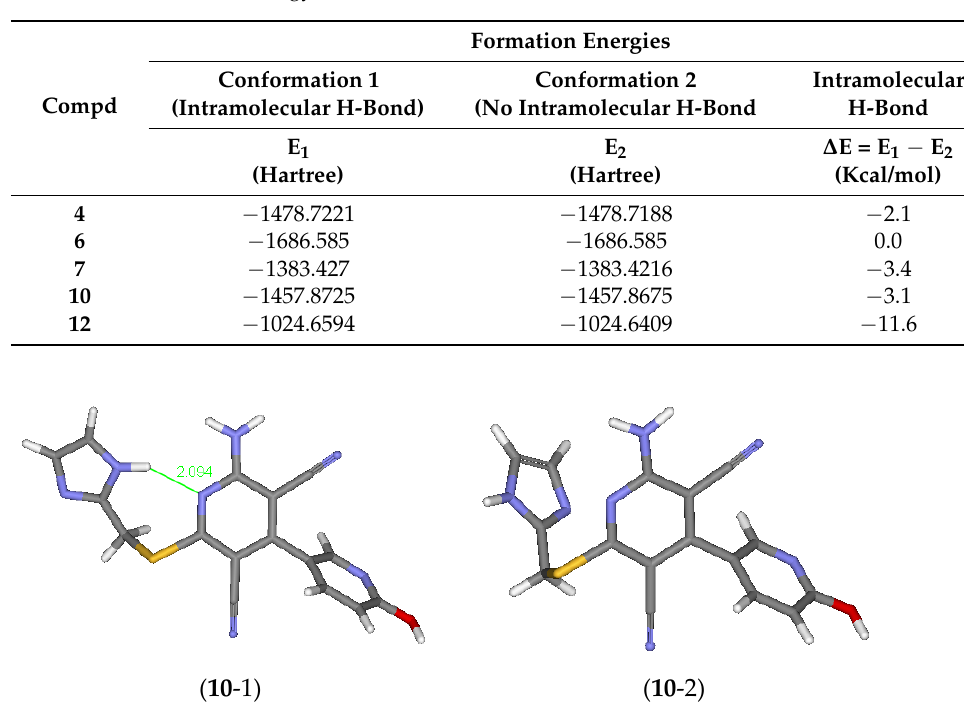
Figure 2. Minimized conformations 1 and 2 of compound 10